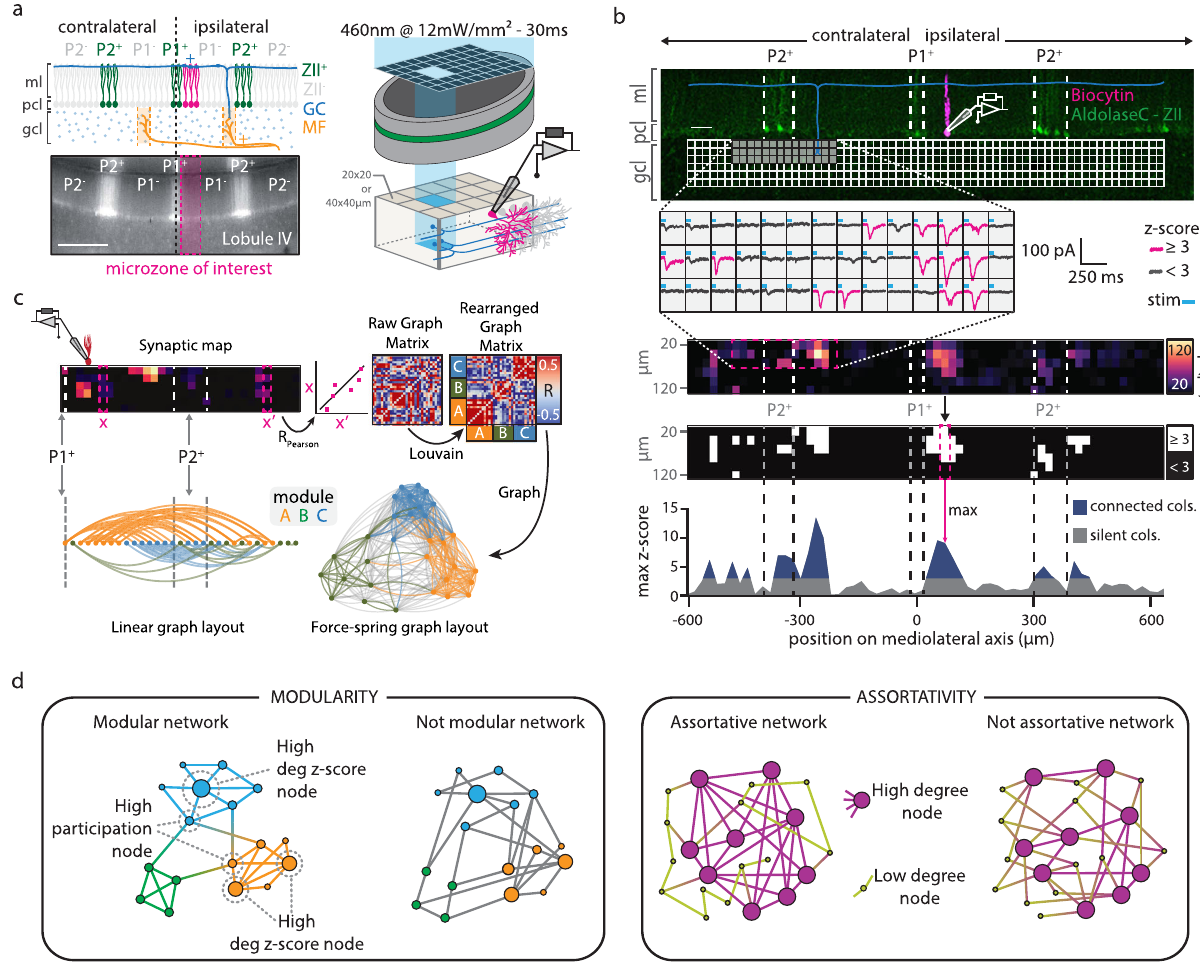
Fig. 1 Description of GC-PC synaptic maps and pro fi les. a Schematic diagram (top left panel) and corresponding picture of an acute slice from an ALDOC- Venus mouse (bottom left panel) illustrating cerebellar cortical anatomy. Recorded PCs (red) are close to the midline (<130 μ m) and belong to the P1 − microzone of lobule III/V. Zebrin II positive (ZII + , green) and ZebrinII negative (ZII − , light gray) PCs coincide with microzonal boundaries (Supplementary Fig. 1). MFs (orange) project onto columns of GCs. Scale bar = 300 μ m. Right panel, photo-stimulation apparatus for glutamate uncaging using